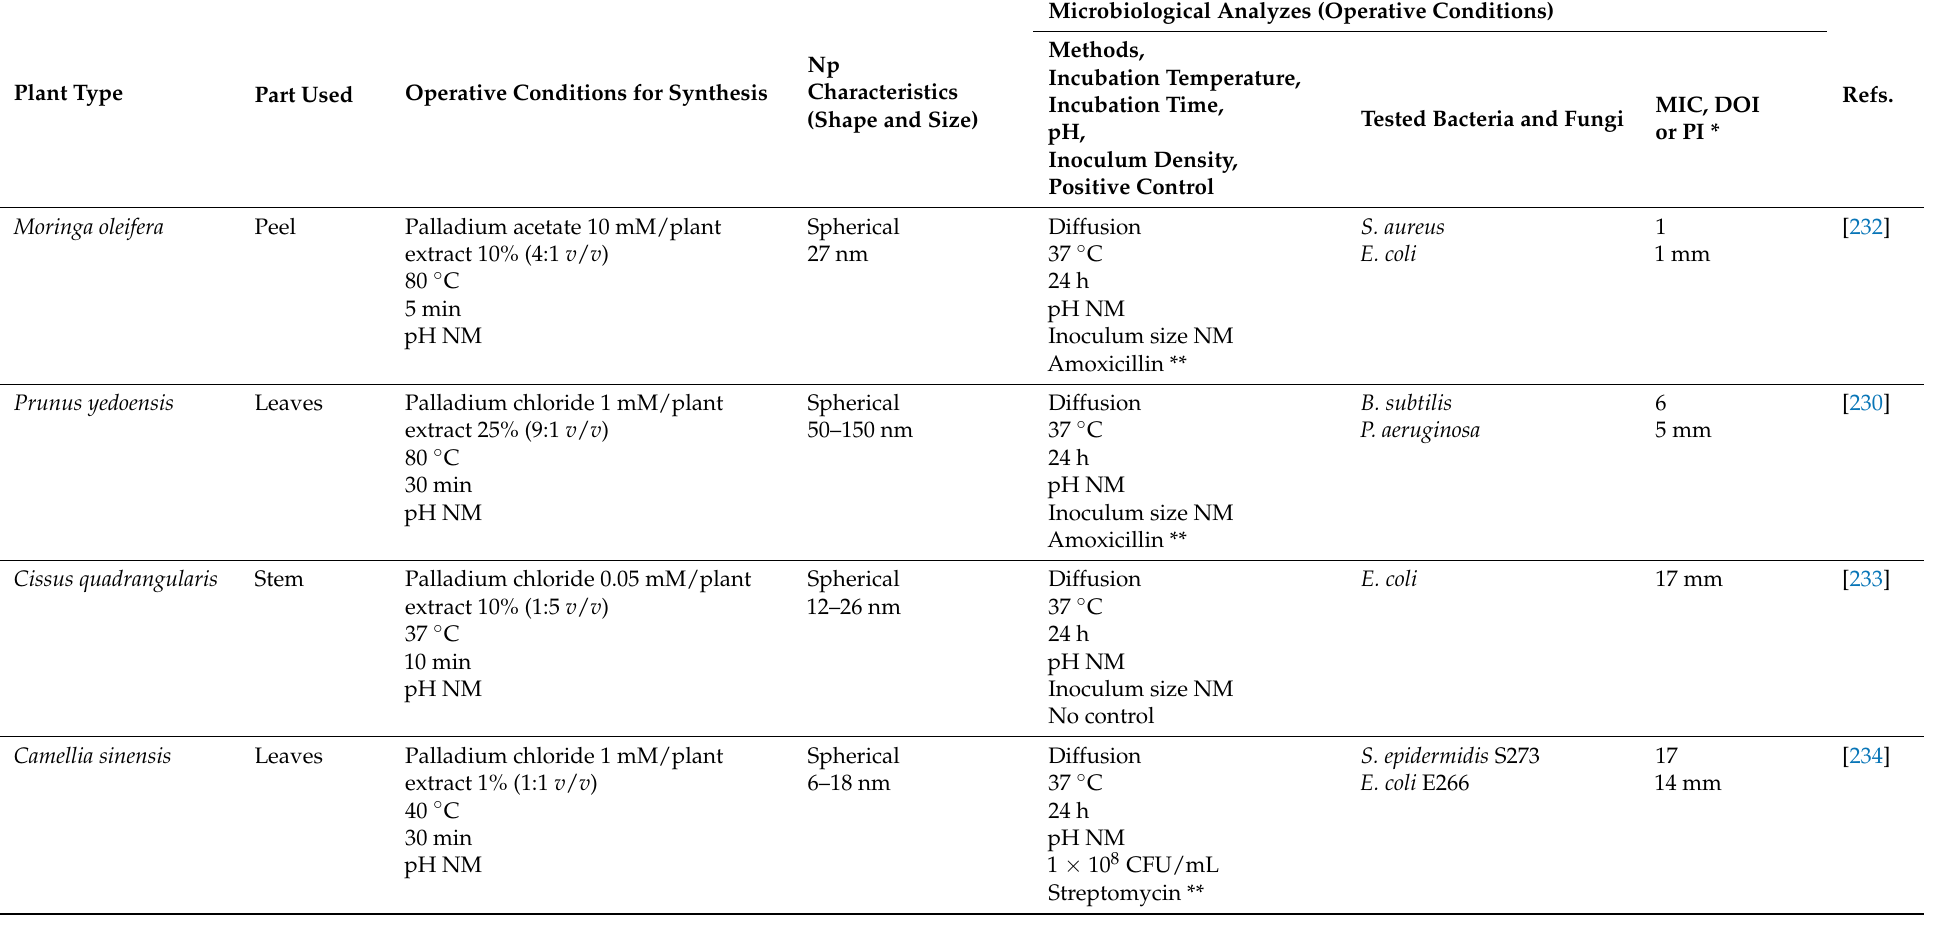
Table 6. Green palladium nanoparticles with antimicrobial